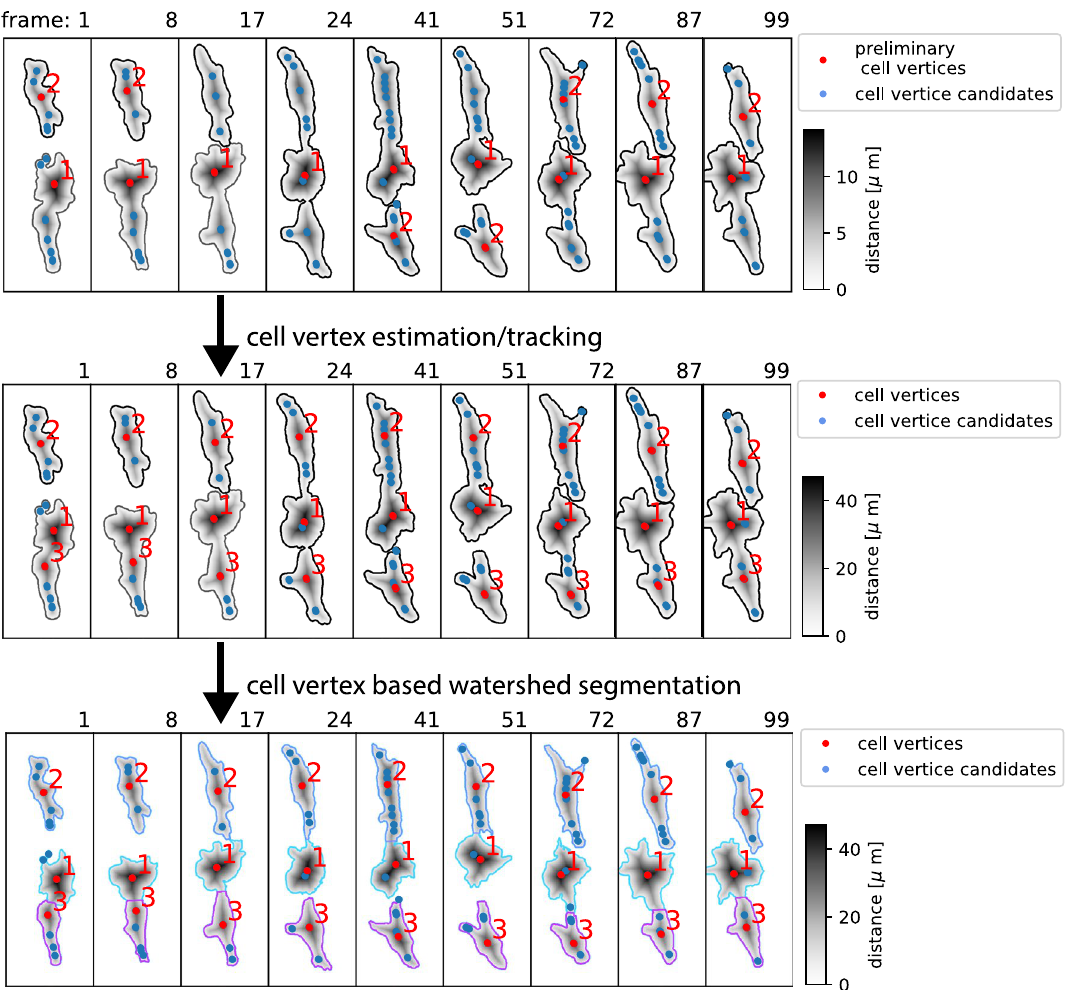
Figure 7. Cell tracking and segmentation refinement the upper sequence, shows the result from our primary segmentation and tracking approach via overlapping labels in neighboring frames. From local maxima within the distance map, we compute the distribution of additional cell vertices. While each frame within the sequence shows three cells, either only one or two are correctly labeled. The center sequence: additional cell vertices are computed by instances where cells (labels) disconnect. In the lower sequence: cells are differentiated through watershed segmentation based on the cell label and the cell vertices.